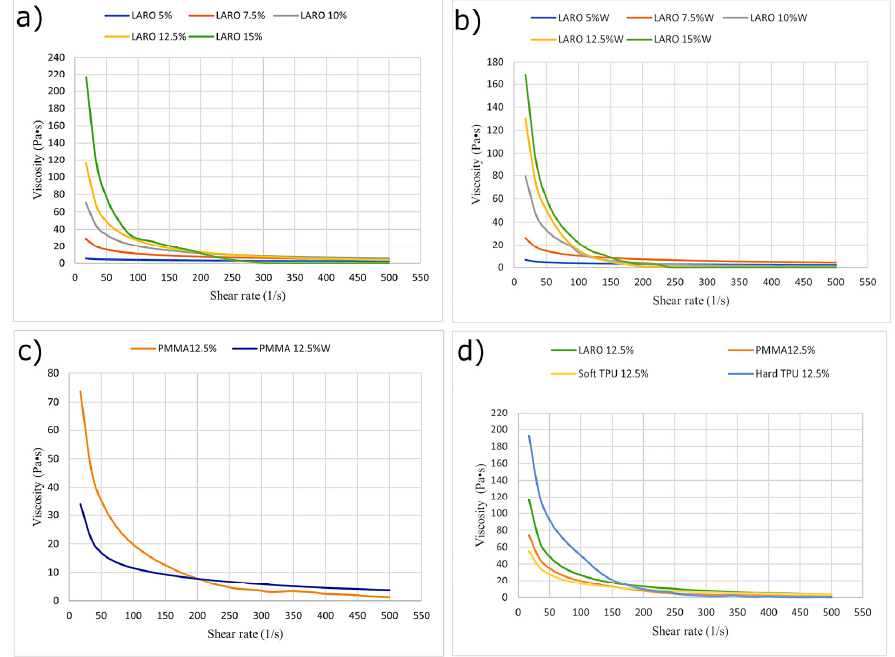
Figure 3. Reliance between viscosity and shear rate for non-rolled LARO pastes ( a ); rolled LARO pastes ( b ); 12.5% PMMA paste before and after the triple rolling process ( c ); pastes of various carriers containing the same graphene amount (12.5%) ( d ).